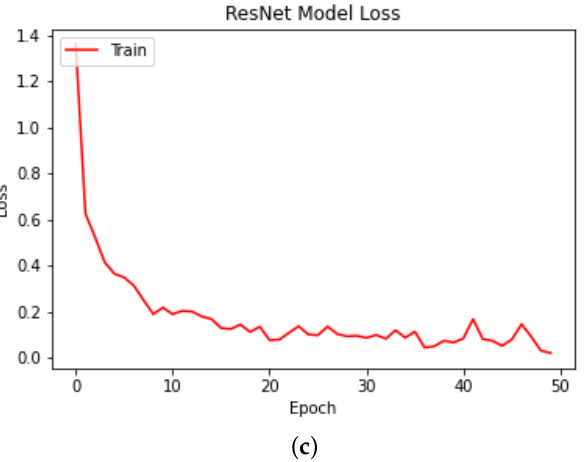
Figure 7. Experiment 2 results: ( a ) confusion matrix, ( b ) ResNet model accuracy, and ( c ) loss versus number of